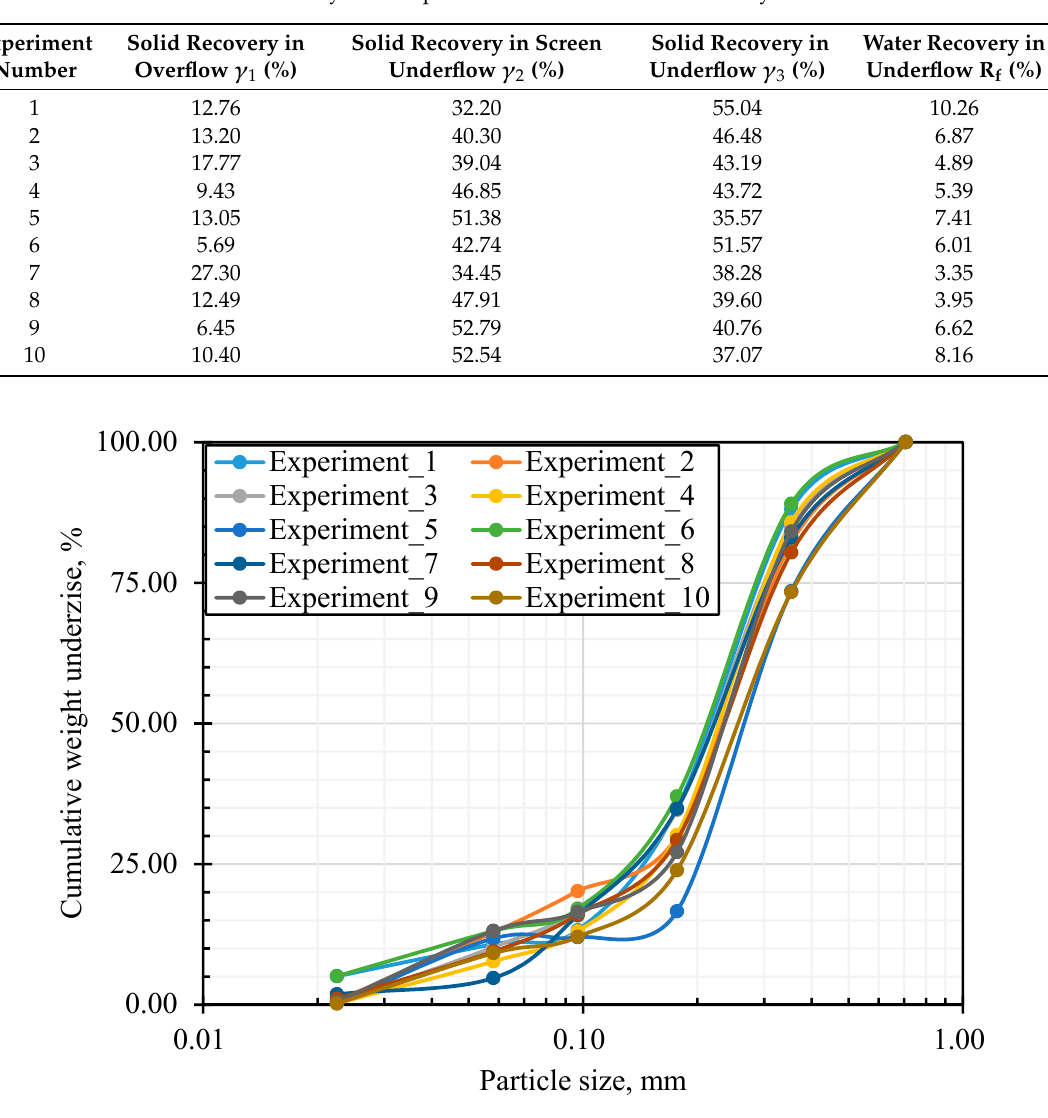
Figure 4. Corrected partition curves of TPHS.